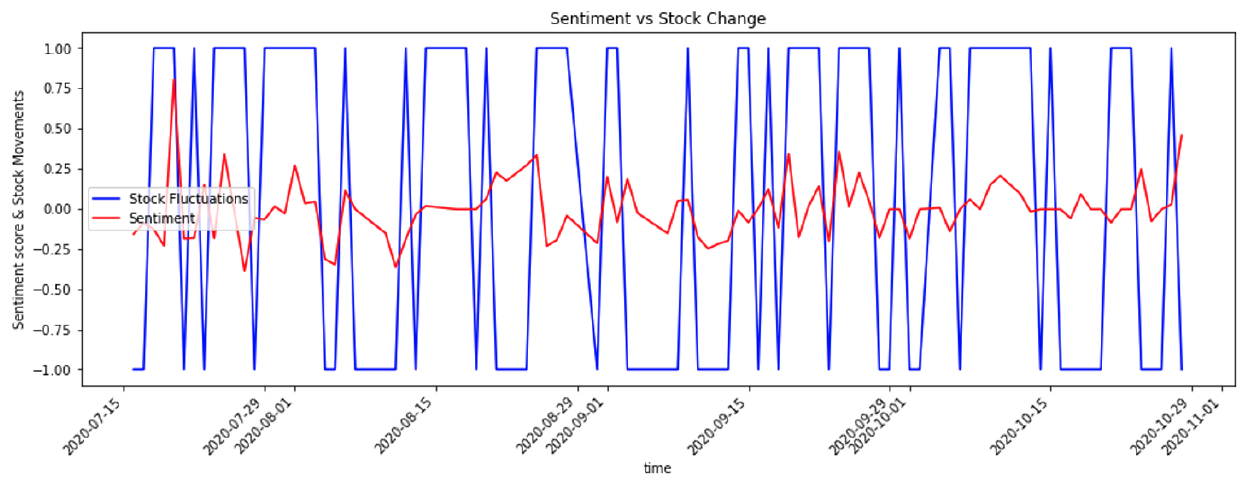
Figure 5. Sentiment and stock change for ‘StockTwits with TextBlob’ dataset.